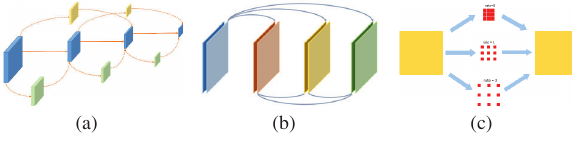
Figure 3. Illustrations of Large-scale Residual Connection, Dense Block and ASPP. (a) Large-scale Residual Connection. The blue block means a stage in the backbone network; others refer to convolutional layers. (b) The structure of Dense Block. A square here refers to a convolutional layer. (c) Atrous Spatial Pyramid.